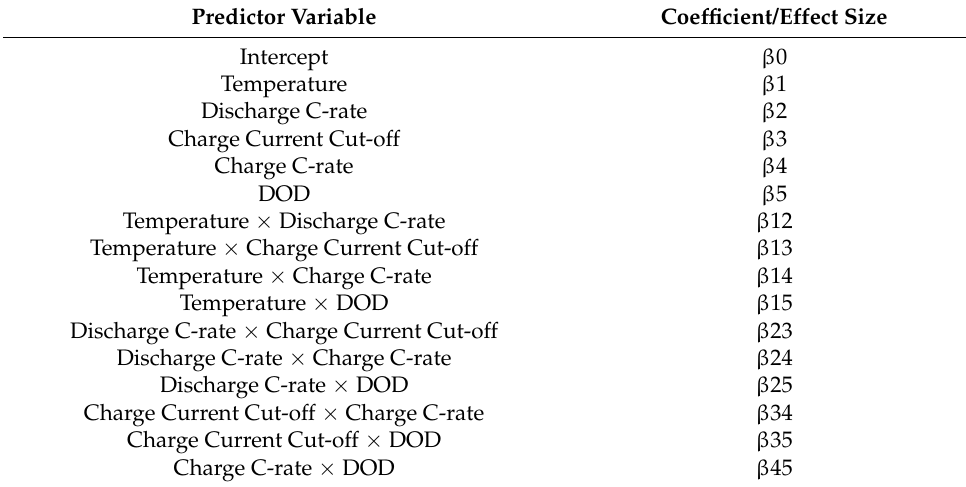
Figure 2. Capacity fade rate (Y) for batteries from Manufacturer 1 for Tests 1–16. Table 2. List of predictor variables and corresponding model